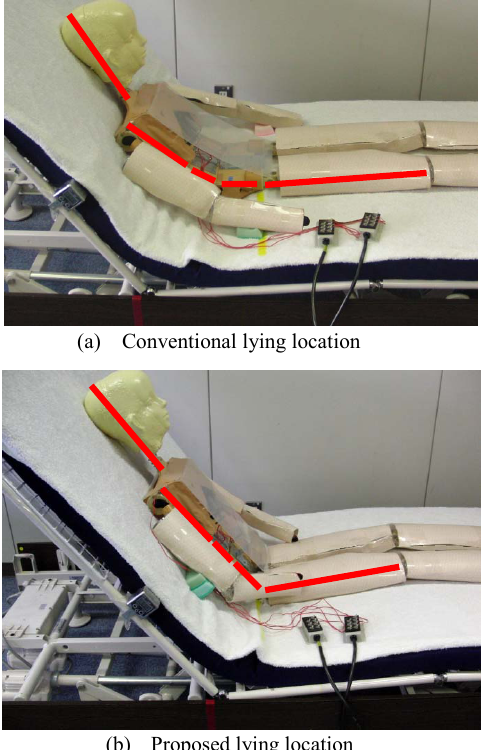
Fig. 5 Postures of the patient dummy during backrest lifting (Gatch up angle 50